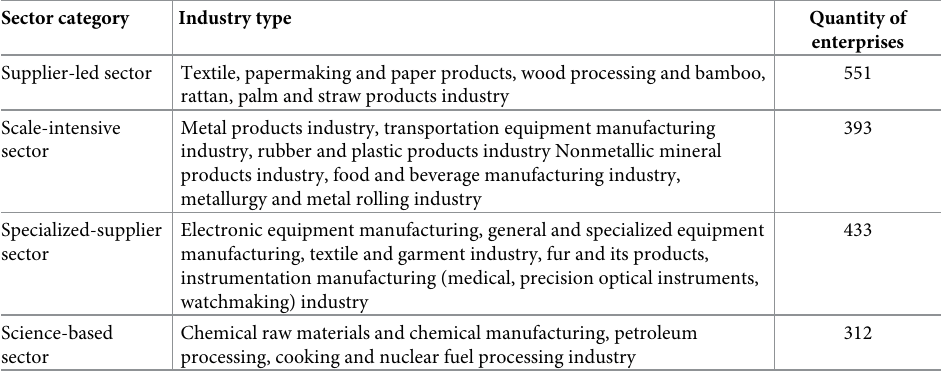
Table 2. Industry classification of sampled